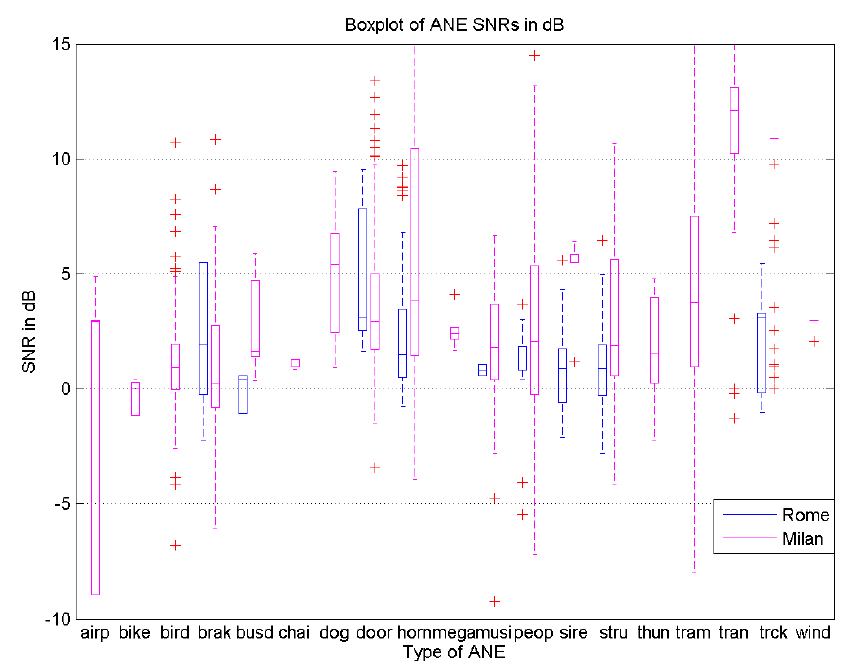
Figure 10. Boxplots of contextual SNR for each ANE type in each of two site locations (urban: Milan and